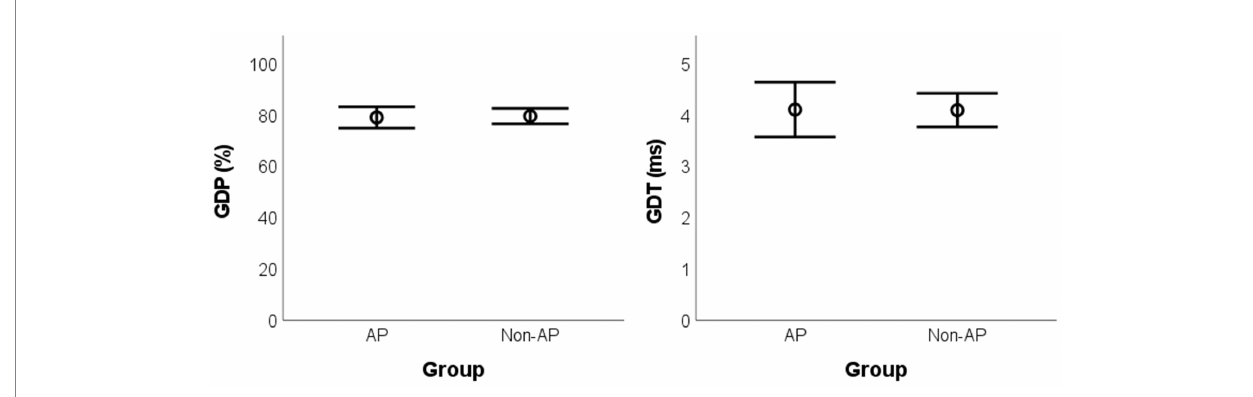
FIGURE 1 Mean values for the GIN parameters according to the group. GIN: Gaps-in-Noise; AP: absolute pitch; GDP: gap detection percentage; GDT: gap detection